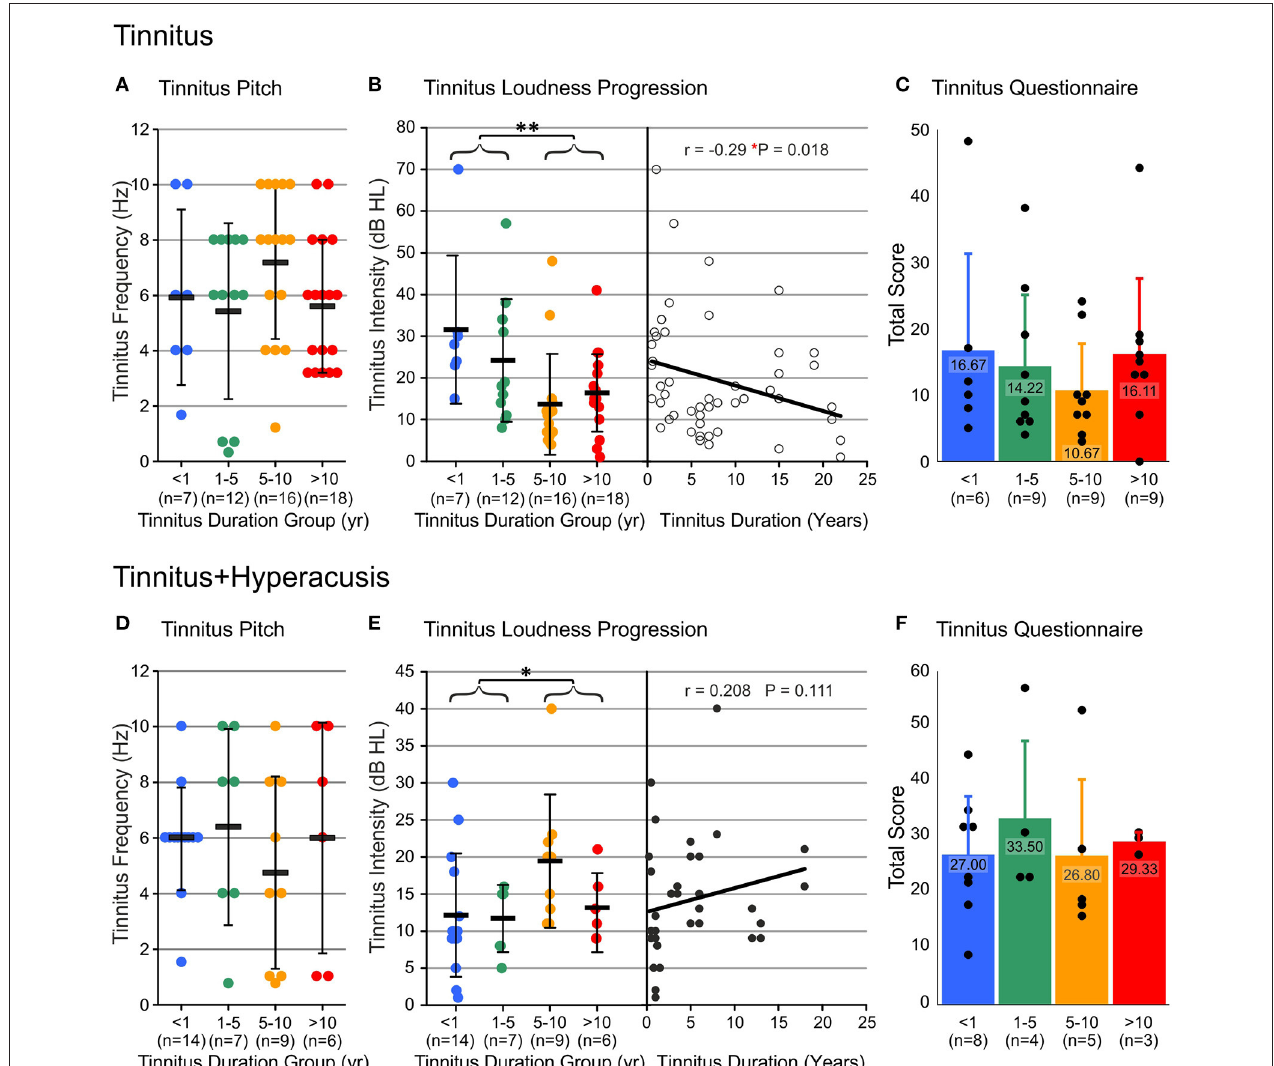
FIGURE 3 | Tinnitus percept significantly changes over tinnitus duration in tinnitus and tinnitus + hyperacusis groups. (A , D) Subjectively matched percept of tinnitus pitch was stable along the time of tinnitus duration in both, tinnitus ( P = 0.070) and tinnitus + hyperacusis ( P = 0.534) participants, calculated with Kruskal-Wallis test. (B , E) The loudness of the tinnitus percept, determined by the intensity of the matching tone decreased over time of tinnitus duration in the tinnitus only group with a statistically significant drop around 5 years ( B , P = 0.005 for < 5 years and > 5 years). In tinnitus + hyperacusis participants, the tinnitus was significantly louder after > 5 years of tinnitus duration, when no more participants with very moderate tinnitus percept could be found ( E , P = 0.015 for < 5 years and > 5 years). Level of significance was calculated with Mann-Whitney U-test is illustrated in the figures (* P ≤ 0.05; ** P < 0.01). A linear trend for the progression of tinnitus loudness over the duration of tinnitus in single ears of the tinnitus group (B) and the tinnitus + hyperacusis group (E) reached statistical significance in the tinnitus group ( B , P = 0.018, n = 52 ears) but not in the tinnitus + hyperacusis participants ( E , P = 0.111, n = 36 ears), for whom the opposite of the trend visible in the tinnitus group was found. (C,F) Total score from Goebel-Hiller Tinnitus Questionnaire indicated a higher affection from tinnitus in the tinnitus + hyperacusis participants than in the participants with only tinnitus (all tinnitus vs. all tinnitus + hyperacusis participants: P < 0.001 using Mann-Whitney U -test, and 2-way ANOVA). Calculation with Kruskal-Wallis test showed no difference between tinnitus and tinnitus + hyperacusis within the tinnitus duration groups. Data show mean ± SD. Single dots show number of ears.